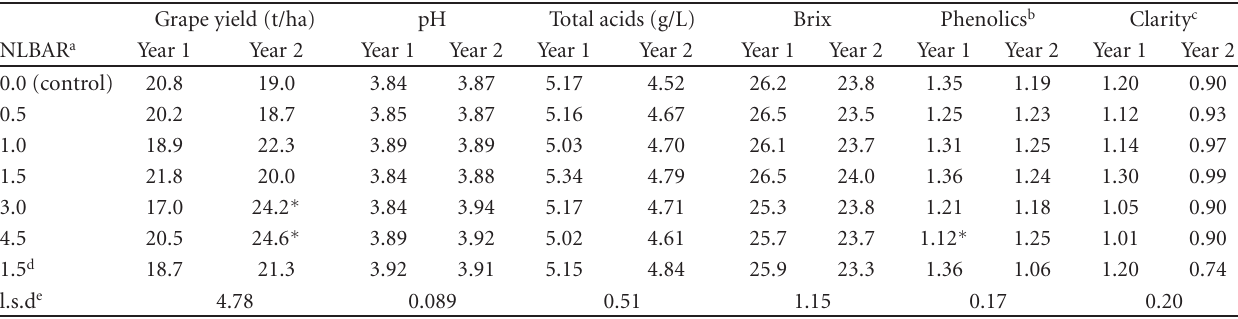
Figure 4: Mean soil total Cd, Cu, and Zn concentrations versus biosolids application rates immediately after biosolids were applied at Mildura in 2004. Table 6: Grape yield and grape properties at the Mildura site from 2004 to